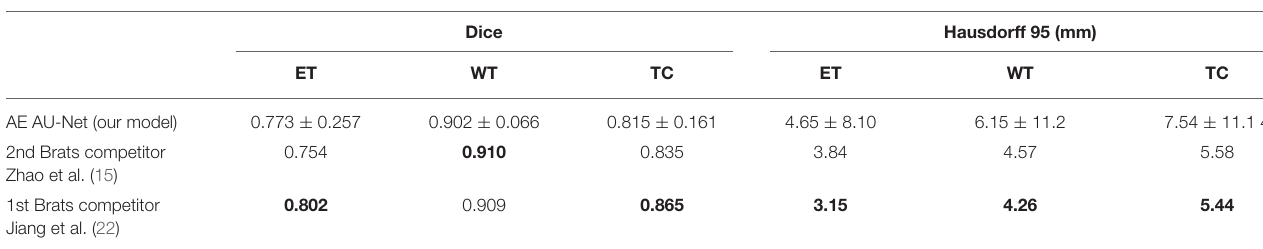
TABLE 4 | Model comparison on BraTS 2019 validation data (125